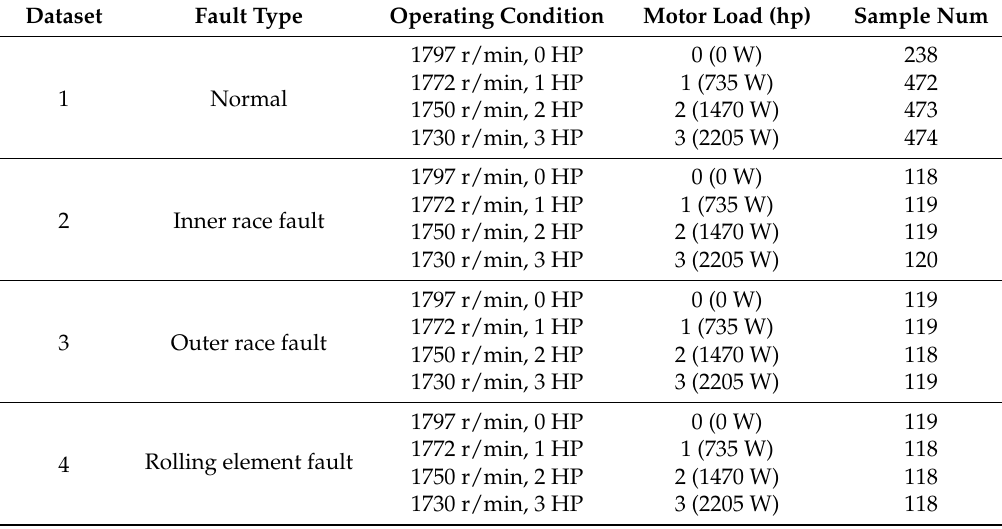
Table 2. Dataset of 0.007 inches (0.178 mm)